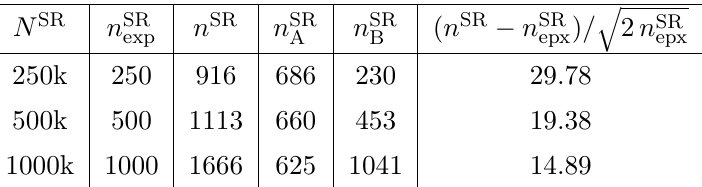
Table 2 . Same as table 1 but for a fixed number of anomalous events N SR with N SR events.